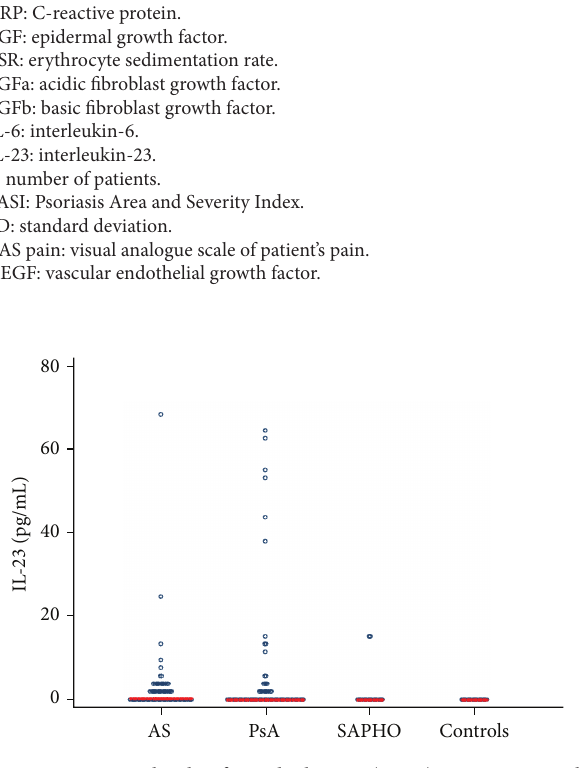
Figure 2: Serum levels of interleukin-23 (IL-23) in patients with psoriatic arthritis (PsA), ankylosing spondylitis (AS), and SAPHO syndrome (SAPHO) and